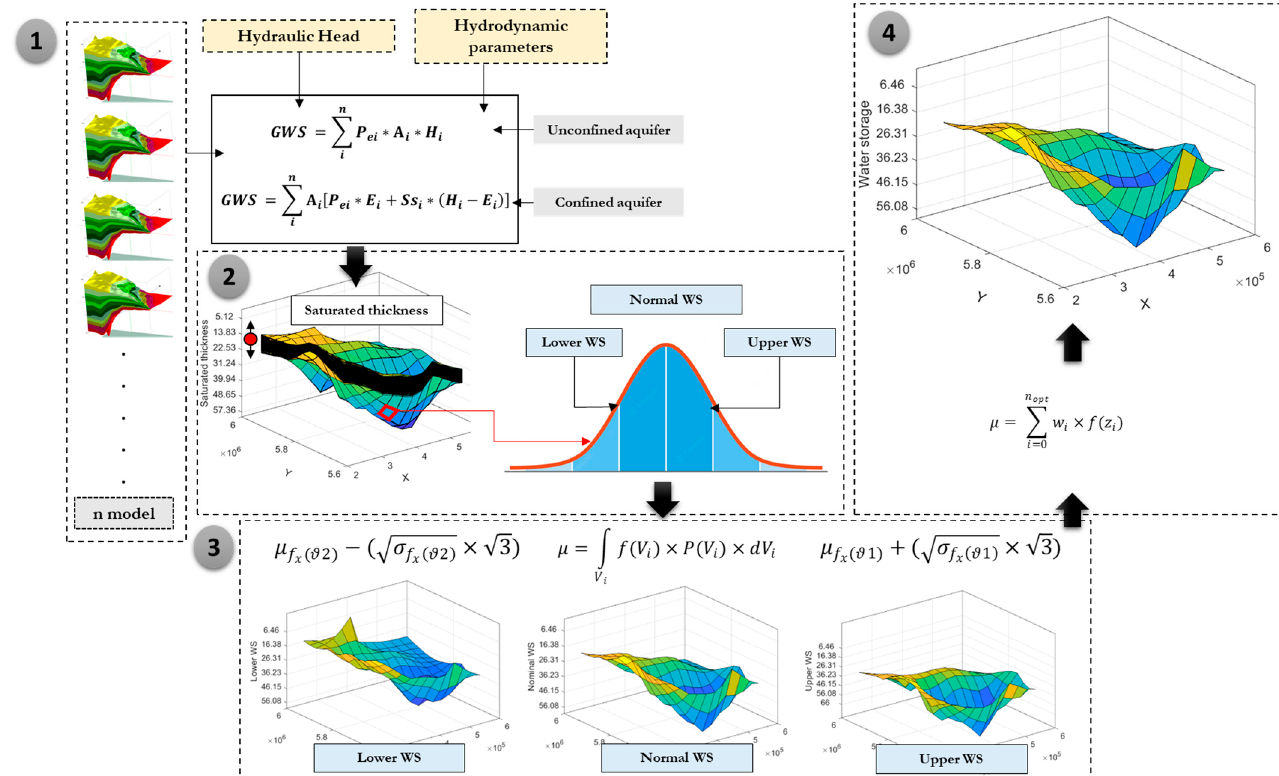
Figure 7. Workflow of the new spatial random bagging simulation (SRBS) system (WS: water storage).